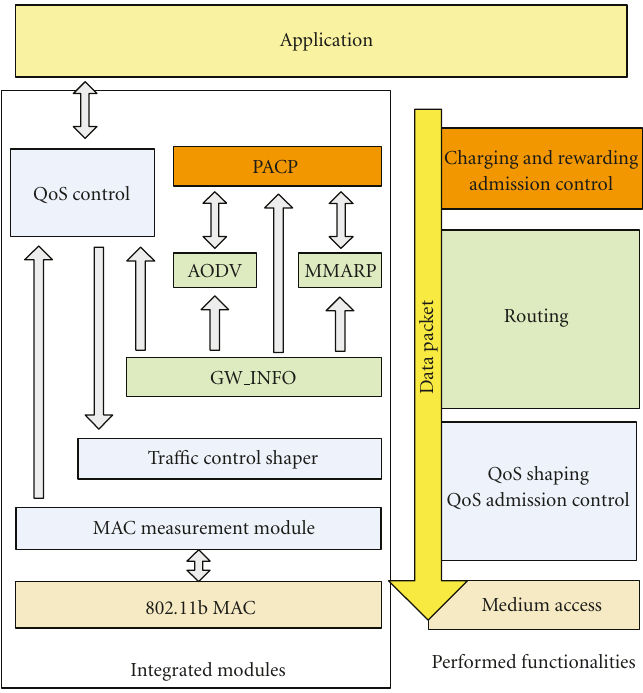
Figure 5: Software